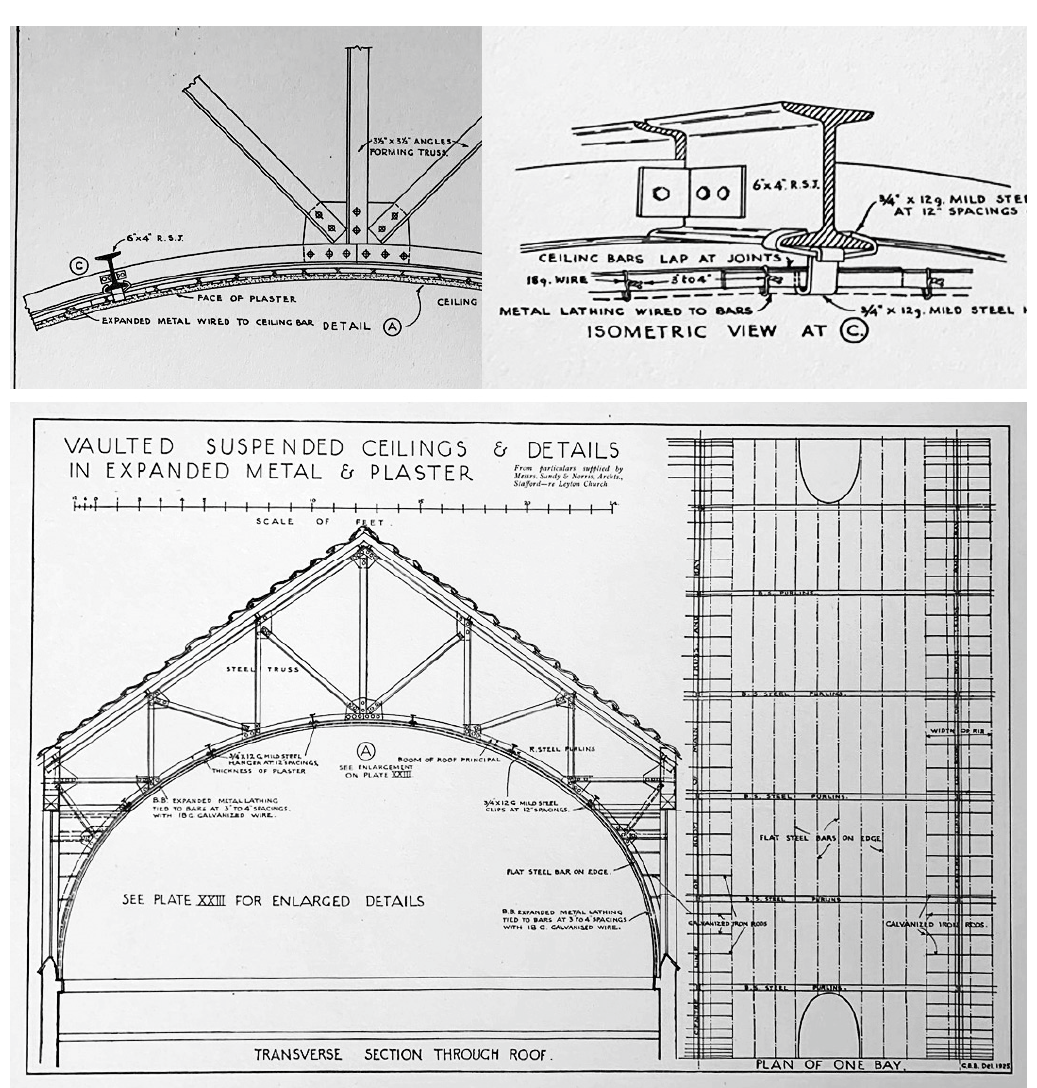
Figure 8. Details from Bankart: Modern plasterwork construction, casting and fixing: fibrous, solid and reinforced 1926 Source: Author.